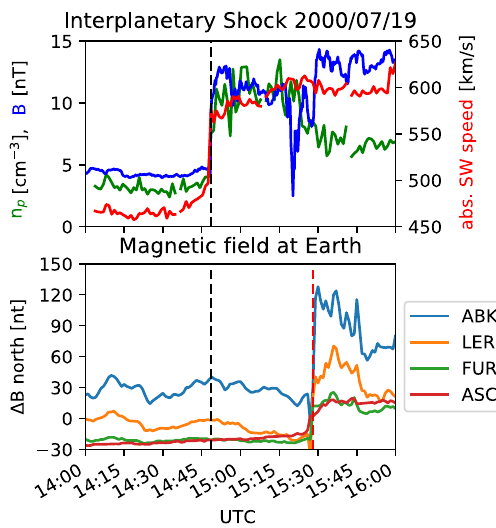
Fig. 1. Top panel shows time series of proton density n p , magnetic fi eld B , and absolute solar wind speed measured by ACE, bottom panel shows magnetic northward component residuals for magne- tometer stations Abisko, Lerwick, Furstenfeldbruck, and Ascension Island, black and red vertical dashed line indicate the interplanetary shock at ACE time 2000/07/19 14:48:35 and a sudden commence- ment in Earth ’ s magnetosphere at 15:27:00 resulting in a delay of 38